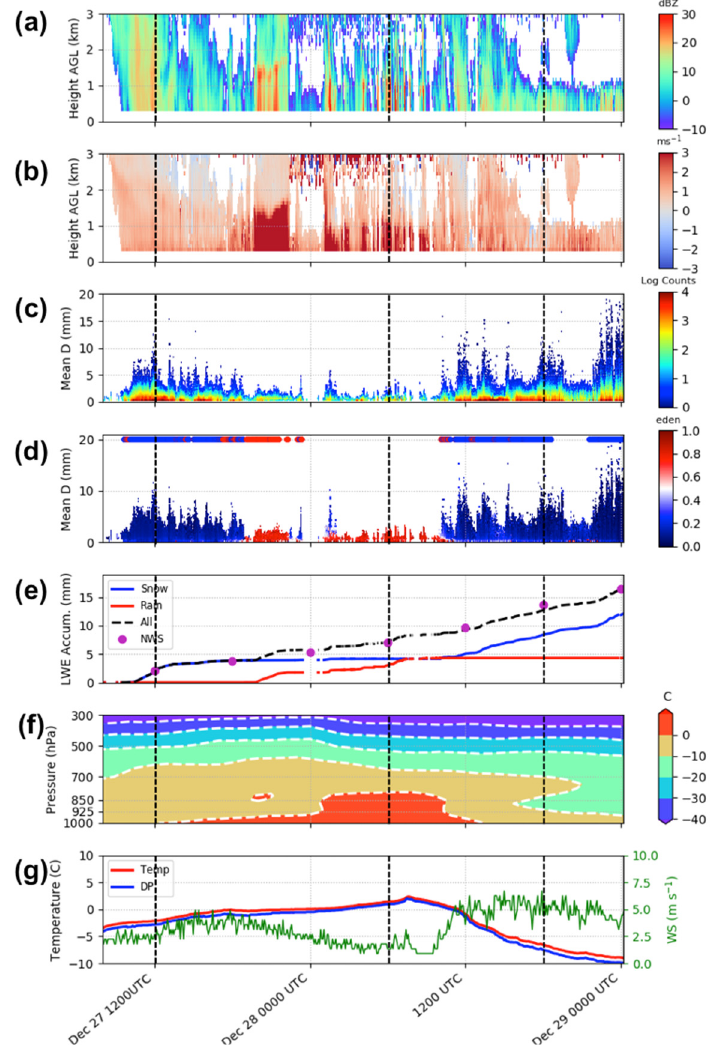
Figure 7. Observations during the 27 to 28 December 2018 event rain-to-snow transition event. Shown are MRR reflectivity ( a ) and Doppler velocity ( b ), PIP PSDs ( c ) and density estimates ( d ), Parsivel hydrometeor identification (d, red and blue dots on the upper portion of the panel), PIP and NWS LWE accumulation ( e ), ERA temperature profiles (red >0 °C) ( f ), and surface temperature, dew point, and winds ( g ). The dashed lines indicate time periods examined in the next figure.